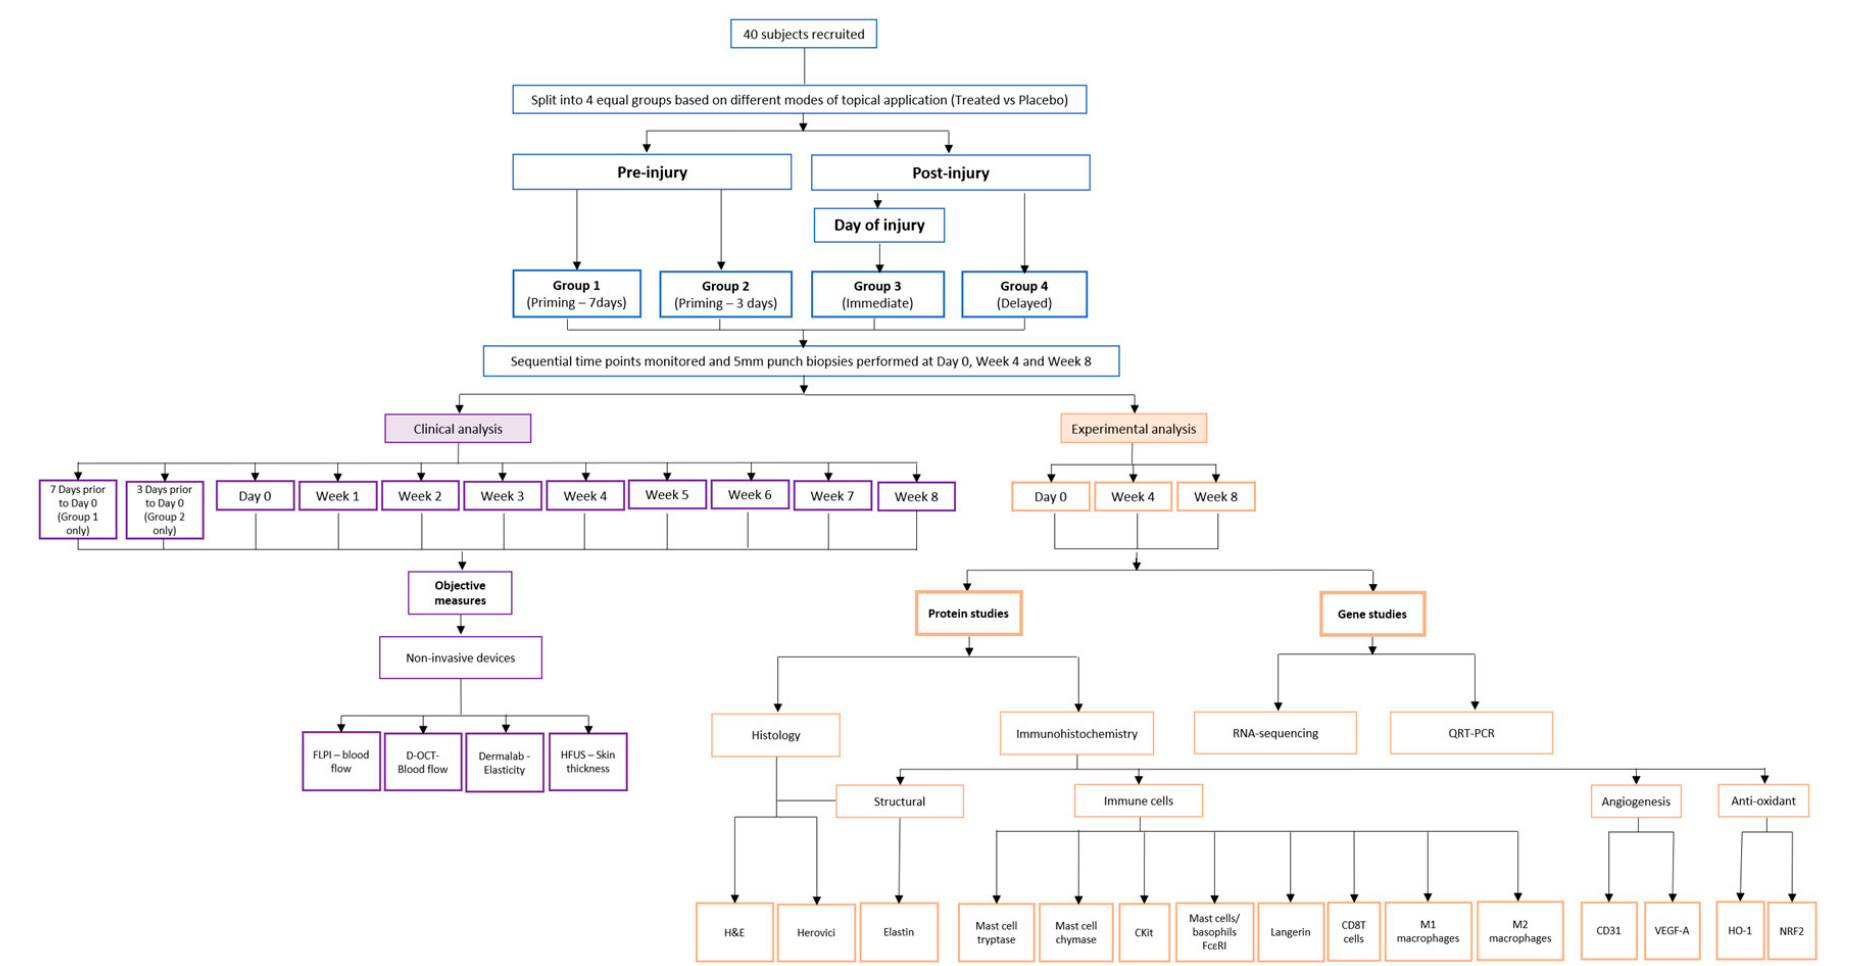
Figure 1. Study Methodology. A flowchart to demonstrate the methodology of the study including both the pre-injury priming versus immediate and post-injury timing of the topical application modalities, study time points and the non-invasive and invasive measures used.